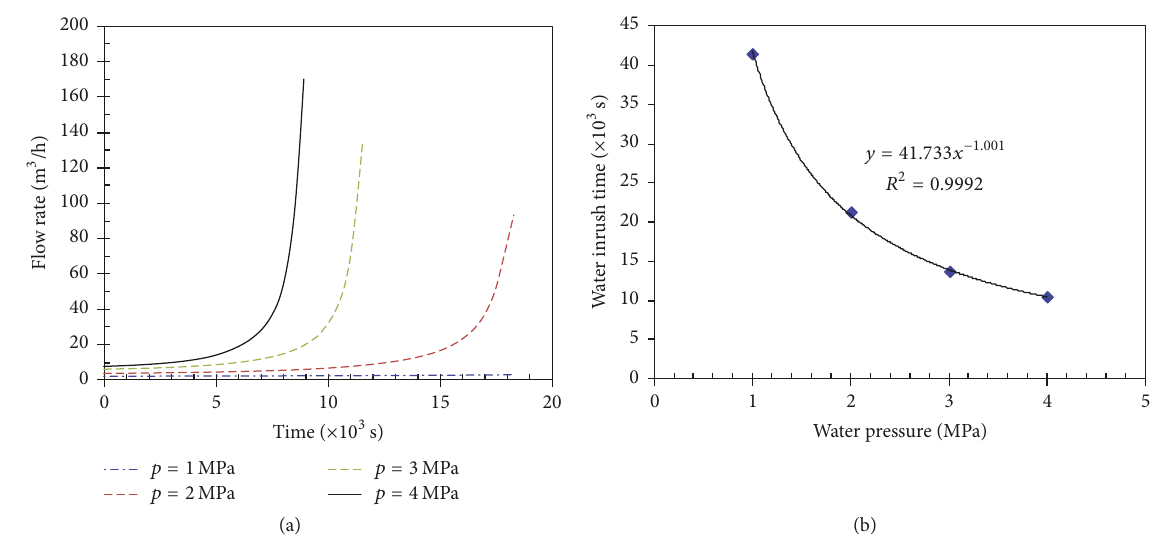
Figure 25: Impact of aquifer water pressure on water flow rate (a) and inrush time